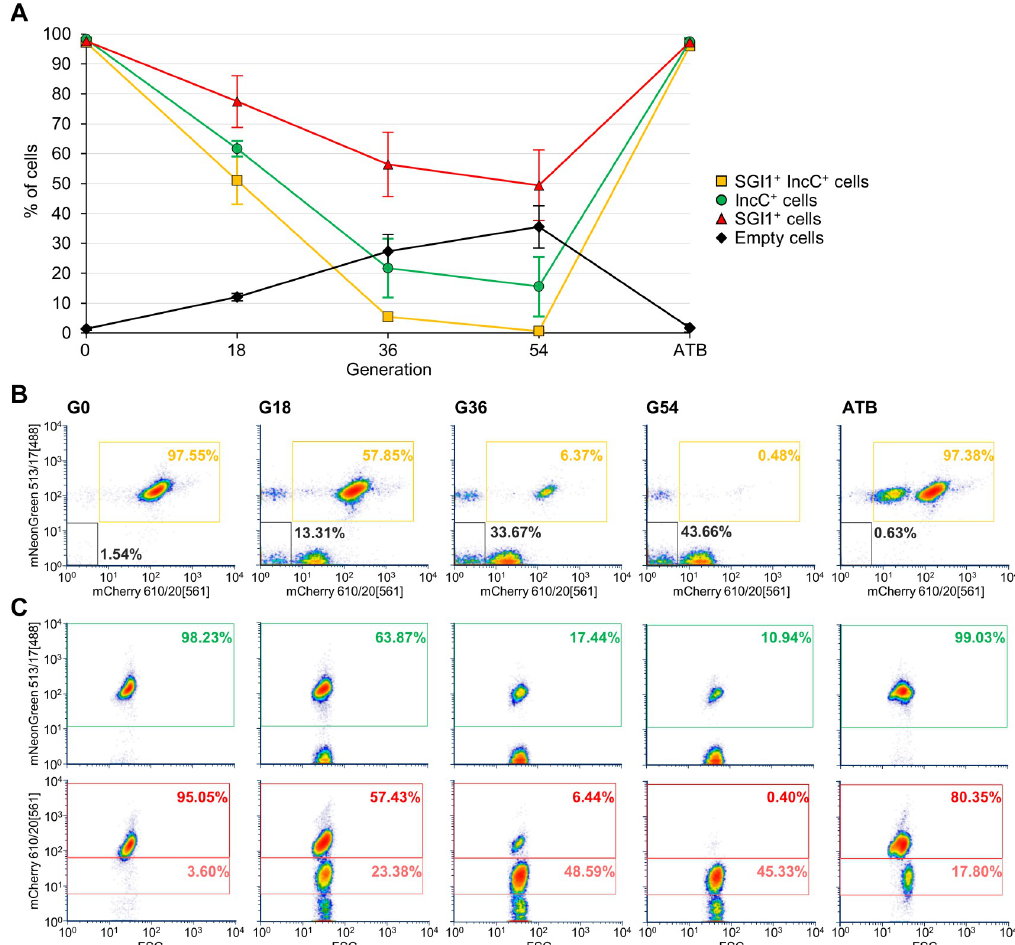
Fig 2. Incompatibility between SGI1 and IncC plasmids is trackable by FC. A. Evolution of the percentage of E . coli KH95 cells bearing SGI1 RedKn (SGI1) and pVCR94 Green (IncC) and grown over 54 generations in the absence of antibiotics as monitored using FC. Plots represent the mean and standard error of the mean obtained from three independent experiments. ATB is a recovery control culture at G54 in LB with selective pressure for both elements. B. Representative FC density plots of the data presented in panel A mapping the green signal (513 nm) as a function of the red signal (610 nm). C. Representative FC density plots of fluorescence intensity over forward scatter corresponding to data presented in panel B. Color keys are identical in all panels. In panel C, pink and red indicate cells producing low- and high-intensity red fluorescence,